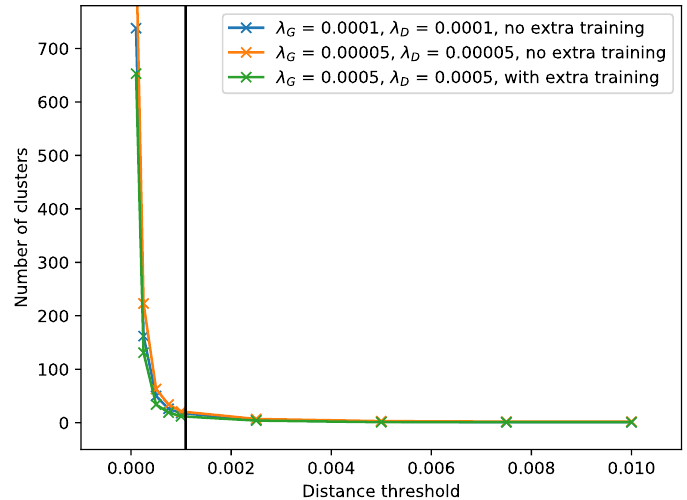
Figure 16. Number of cluster for different